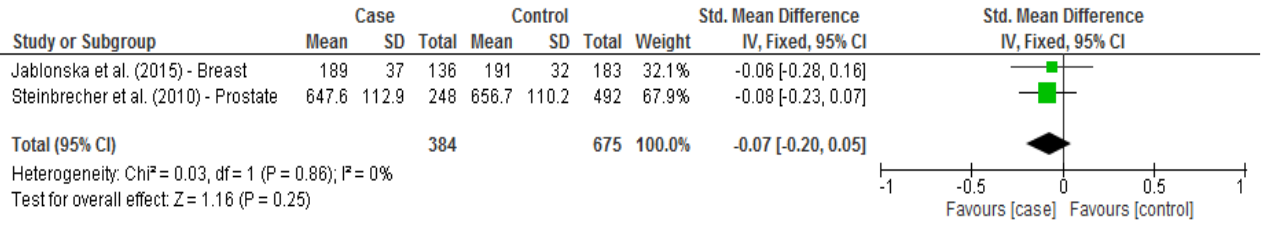
Figure 6. Forest plot of standardized mean difference (SMD) of GPX3 activity between cancer patients and control group [17,37].